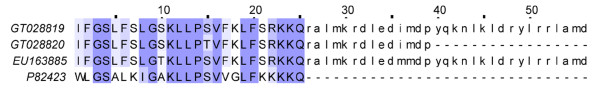
Sequence alignment of Ponericin-like peptides. GT02s represent the dbEST accession numbers for Yunnan-sourced Lychas mucronatus cDNA library. EU15s represent the GenBank accession numbers for Hainan-sourced Lychas mucronatus cDNA library. Lower case amino acids represent putative pro-sequences. P82423 represents Ponericin-W1 from Pachycondyla goeldii (Ponerine ant).